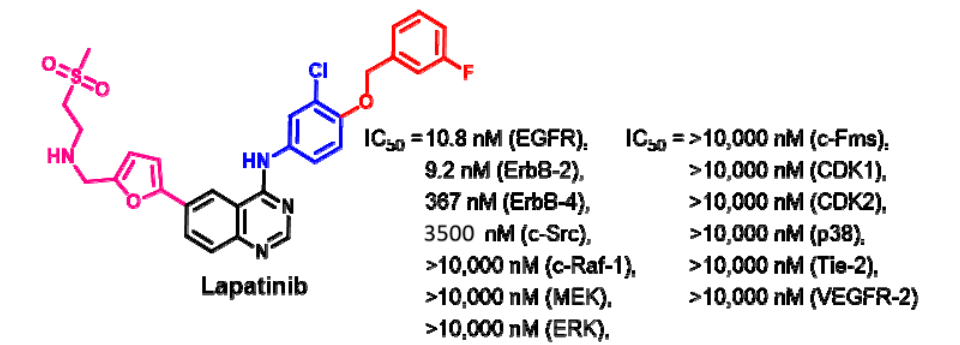
Figure 40. Kinases inhibitory activities of lapatinib. Molecules 2021 , 26 , x FOR PEER REVIEW